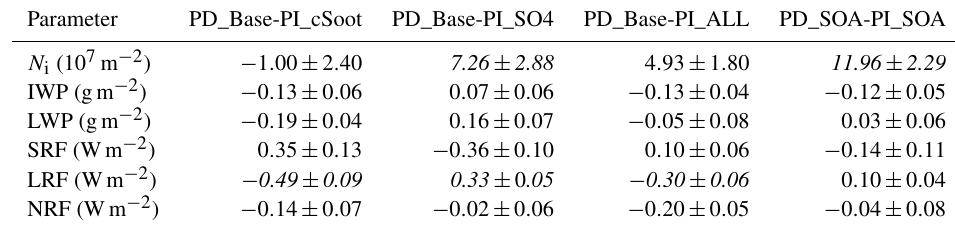
Table 3. Forcing and cloud changes associated with changes in aircraft soot, sulfur, and all anthropogenic aerosols.